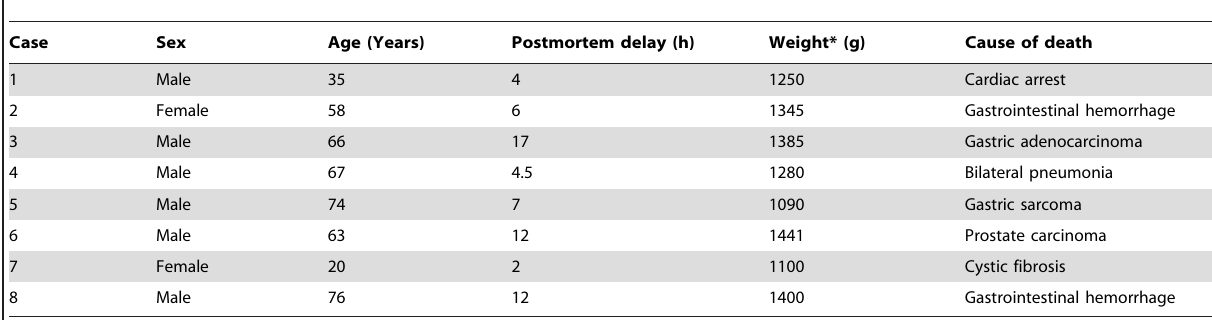
Table 1. Clinical data on the human cases used in this study.